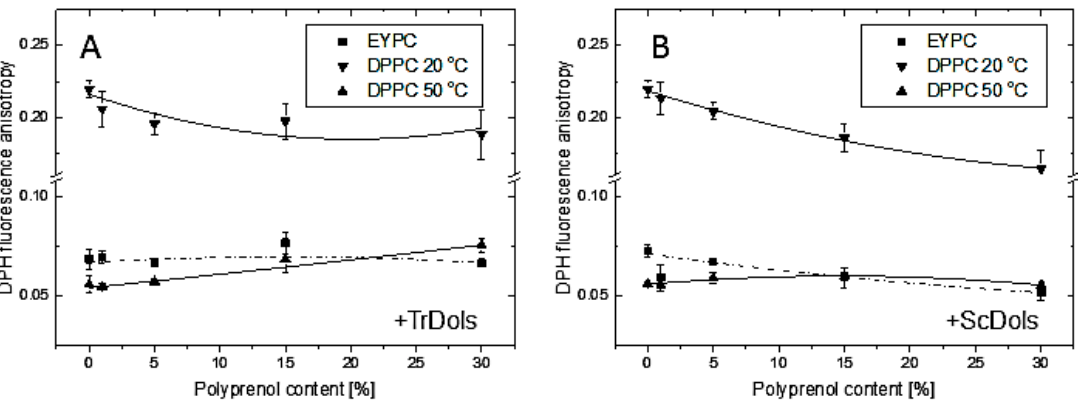
Figure 11. Influence of concentration of dolichol on fluorescence anisotropy of l,6-diphenyl-l,3,5-hexatriene (DPH) in egg yolk lecithin (EYPC) and 1,2-dipalmitoyl- sn -glycero-3-phosphatidylocholine (DPPC) liposomes. DPH fluorescence anisotropy in EYPC and DPPC multilamellar vesicles containing different amount of TrDols ( A ) and ScDols ( B ) Continuous lines between points represent theoretical fits to the experimental data by applying equation: y = Intercept + B1 × x 1 + B2 × x 2 (Table S2).